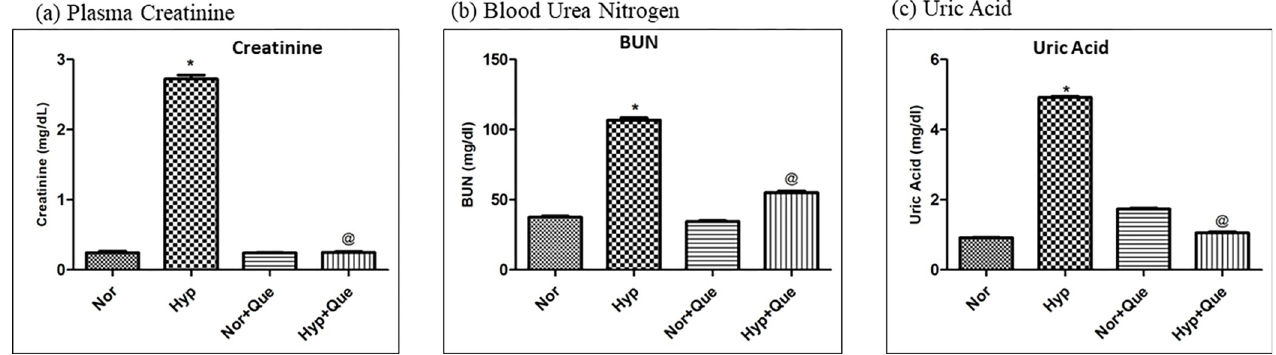
Fig 9. Effect of quercetin supplementation (50mg/Kg BW) in kidneys of rats exposed to 7,620m for 12h at 25 ± 2˚C (a) Plasma Creatinine (b) Plasma BUN (c) Plasma Uric Acid levels � p < 0.001 Norm v/s Hypo 12h; @ p < 0.001 Hypo v/s Hypo+ Que. Norm-Normoxia control, Hypo 12h- hypobaric hypoxia exposure for 12h, Norm+ Que-Quercetin administered to normoxia control, Hypo+ Que- Quercetin administered hypoxia exposure of 12h. Norm- Normoxia, Hypo-Hypoxia; Que- Quercetin (50mg/kg BW).